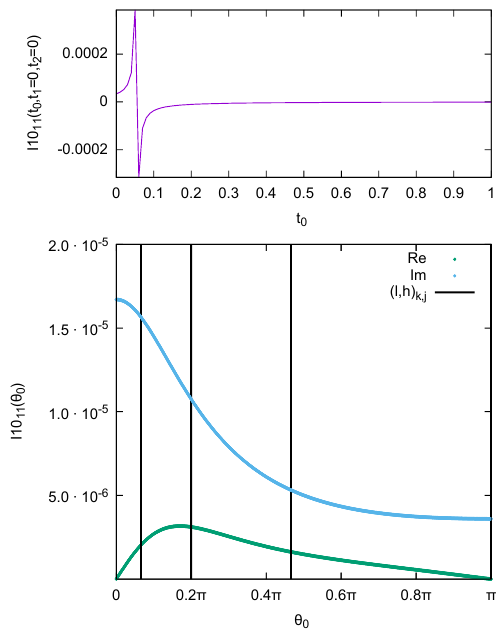
Figure 8 . Plot of the one dimensional integrand of eq. (3.6), with chosen values m 2 = 781 : 25 GeV and m 1 = 173 GeV. The upper plot shows the integrand without, the lower plot shows the integrand with the implementation of the Feynman +i (cid:14) prescription. The partitioning of the integral according to eq. (2.11) is illustrated by the black